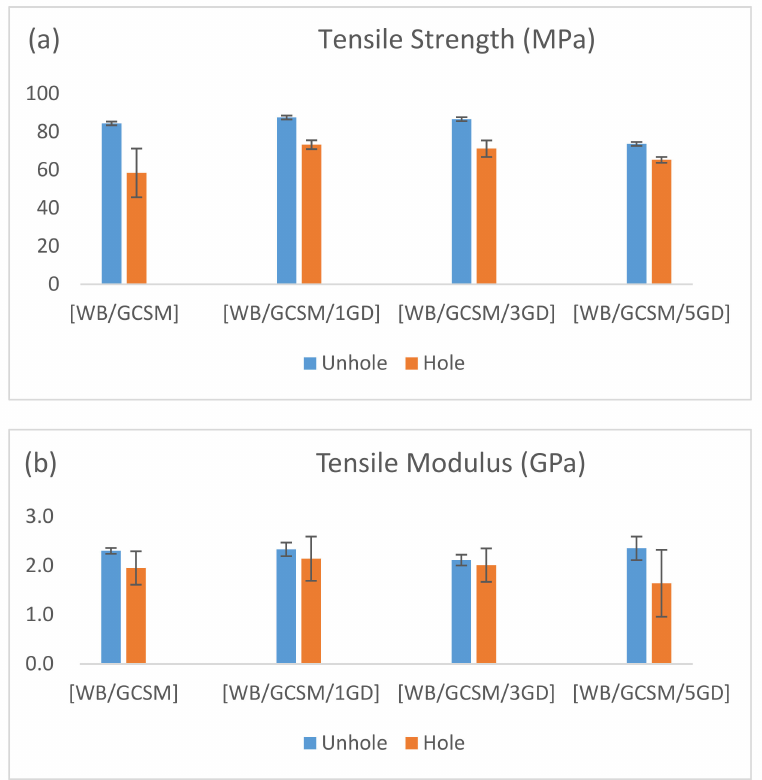
Figure 3. UHT and OHT properties of [WB/GCSM], [WB/GCSM/1GD], [WB/GCSM/3GD] and [WB/GCSM/5GD] composites ( a ) Tensile strength and ( b ) Tensile